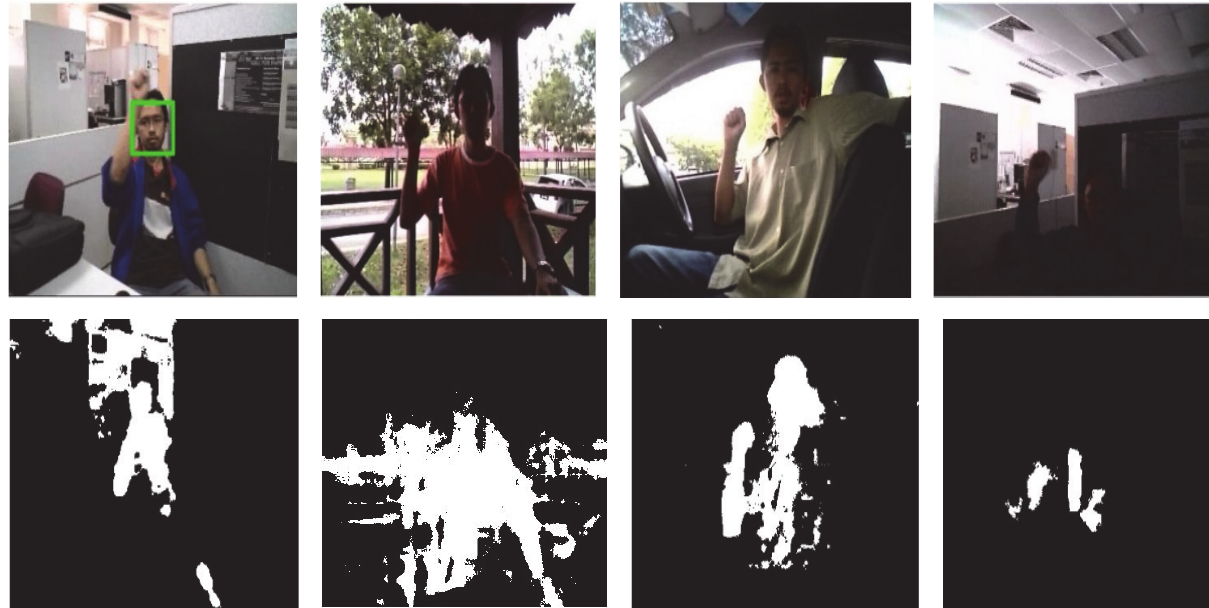
Figure 8: Experimental results of skin colour segmentation using offline training thresholds procedure.